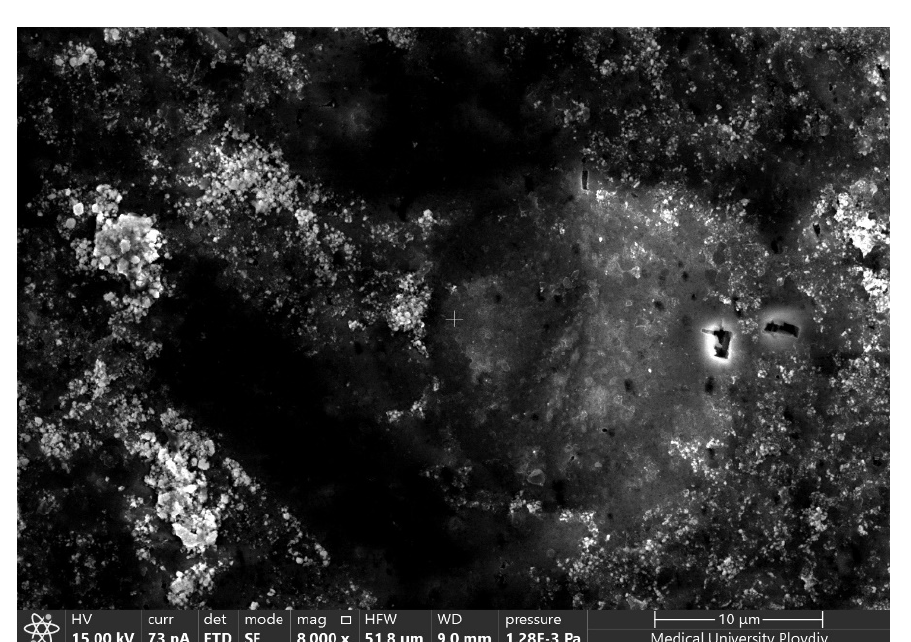
Figure 8. Microphotograph of specimen of group AE-8 at ×8000 magnification.